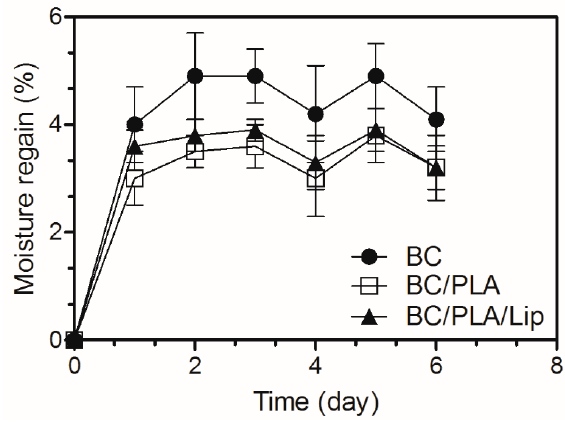
Figure 7. Moisture regain of BC, BC/PLA, and BC/PLA/Lip mats.